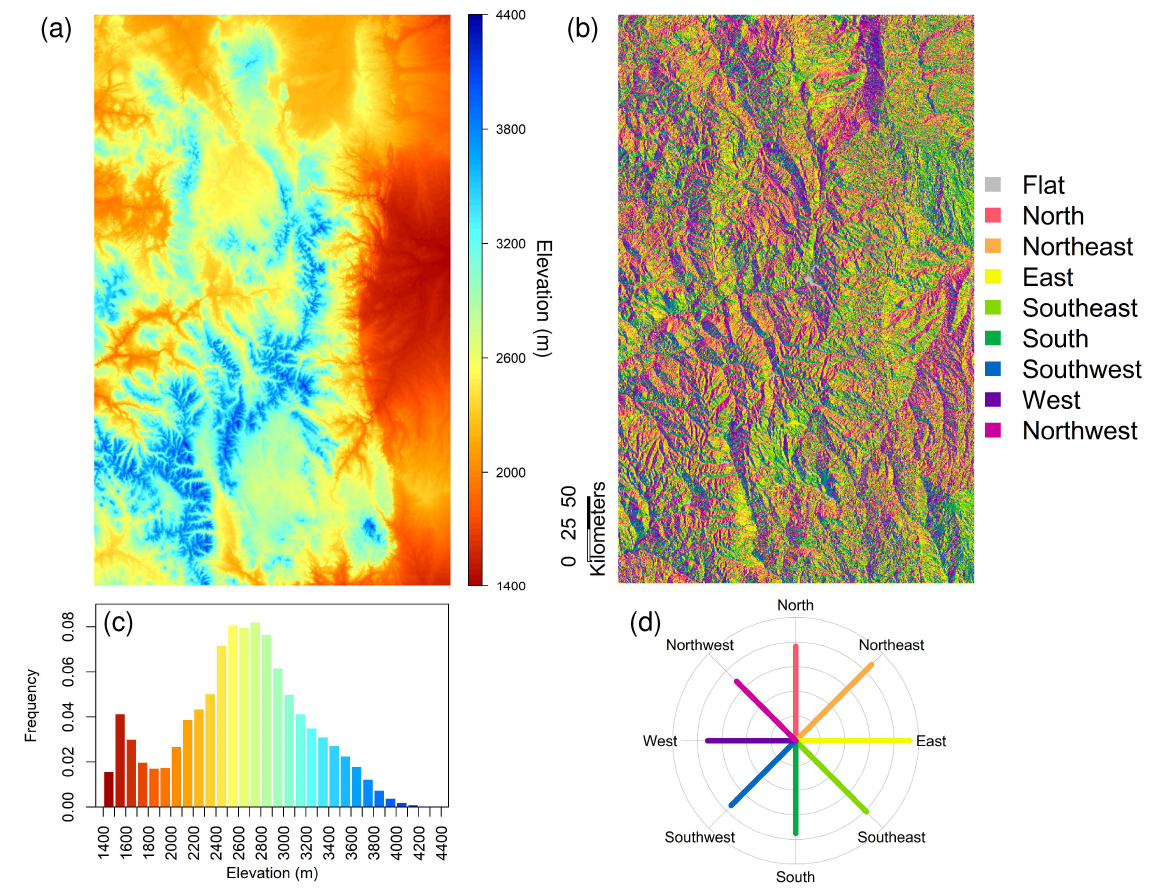
Figure A5. Digital elevation model for the region of interest ( a ), and the corresponding aspect categorized as North, Northeast, East, Southeast, South, Southwest, West, Northwest, and Flat ( b ). Frequency of elevations ( c ) and relative frequency of aspects ( d ) for the stream network of interest. The frequency of the flat aspect is not depicted, and it corresponds to only 0.4% of the